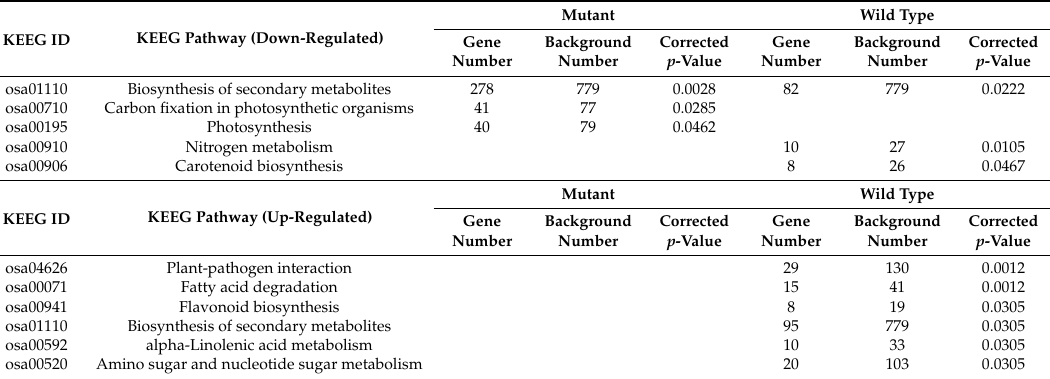
Table 4. Significantly enriched pathways in the OsVHA-A mutant and wild type by Kyoto Encyclopedia of Genes and Genomes (KEGG) Orthology Based Annotation System (KOBAS) during leaf senescence (Corrected p -value < 0.05).